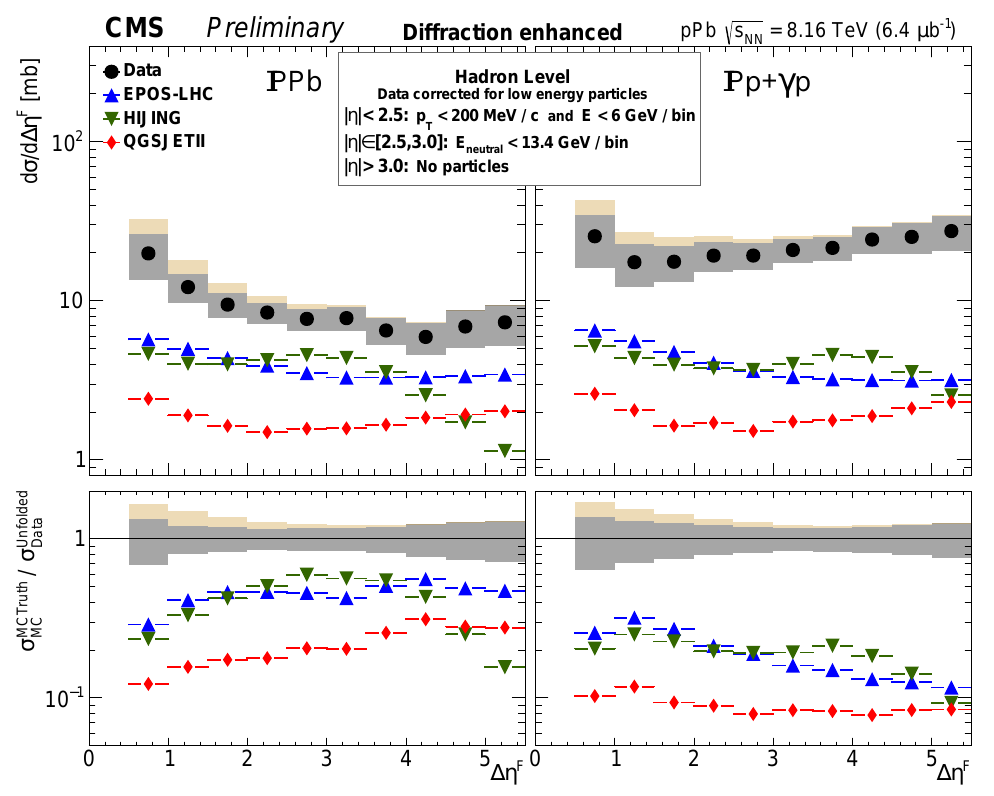
σ Figure 2: Top: the hadron level d distribution with no energy deposition in the d ∆ η F 3.15 < | η | < 5.2 region adjacent to FRG for the CMS data [ 16 ] (black), and the predictions of the EPOS-LHC [ 24 ] (blue), QGSJET II [ 25 ] (red) and HIJING [ 26 ] (green) event generators. The distributions are shown for the IPPb (left) and IPp topologies. Bottom: ratios between generator predictions and CMS